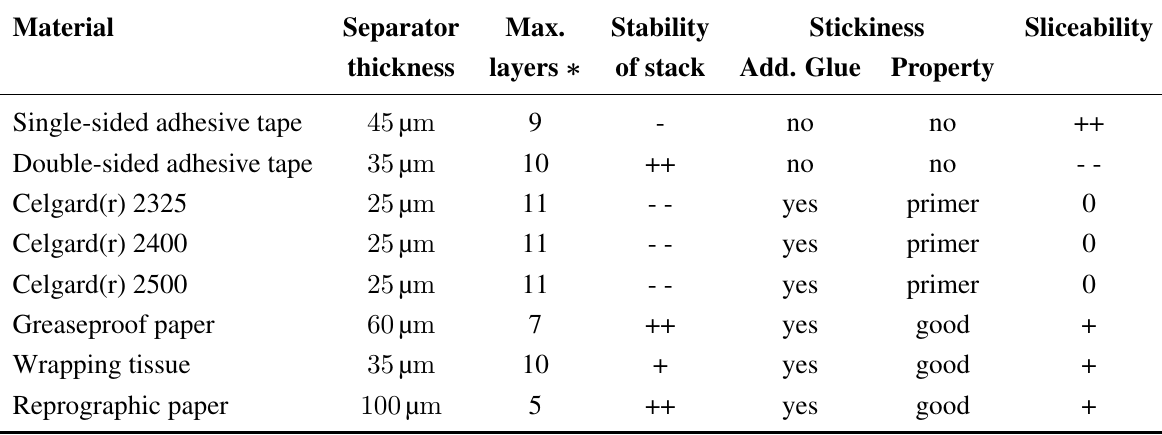
Table 2. Overview of the separation materials and stack